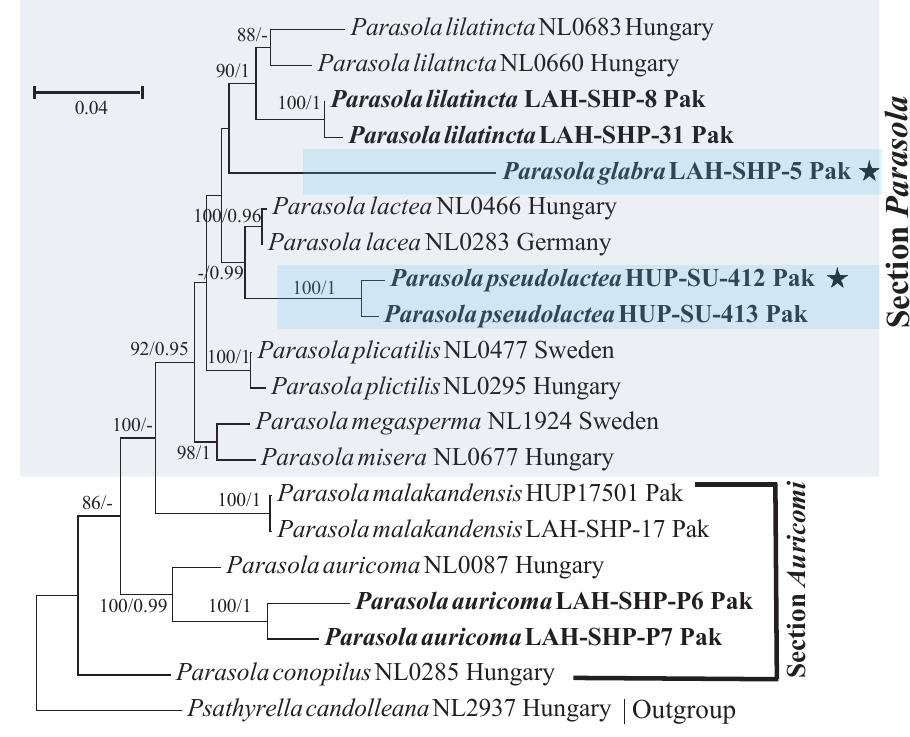
Figure 3 . Phylogeny of Parasola species based on 20 sequences of combined ITS-28S- TEF1 α dataset. Our sequences are indicated in boldface. Other sequences are from Nagy et al. (2009, 2011). Numbers above or below branches indicate maximum likelihood bootstrap percentages followed by Bayesian poste- rior probabilities. Species in section Parasola are light-brown highlighted where the new species are shown as light-blue, while the HOLOTYPE collection for P. glabra (LAH-SHP-5) and P. pseudolactea (HUP- SU-412) are represented by stars